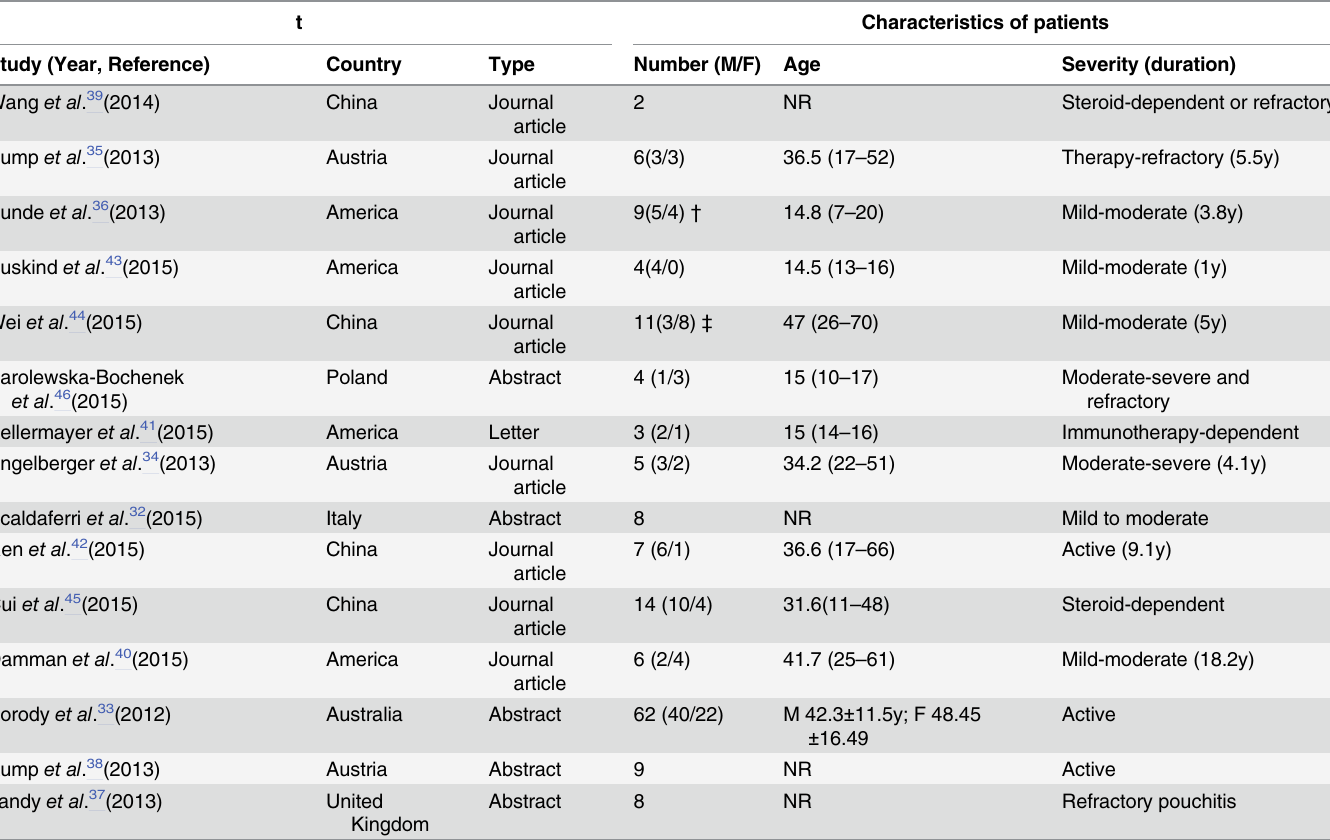
Table 1. Characteristic of cohort